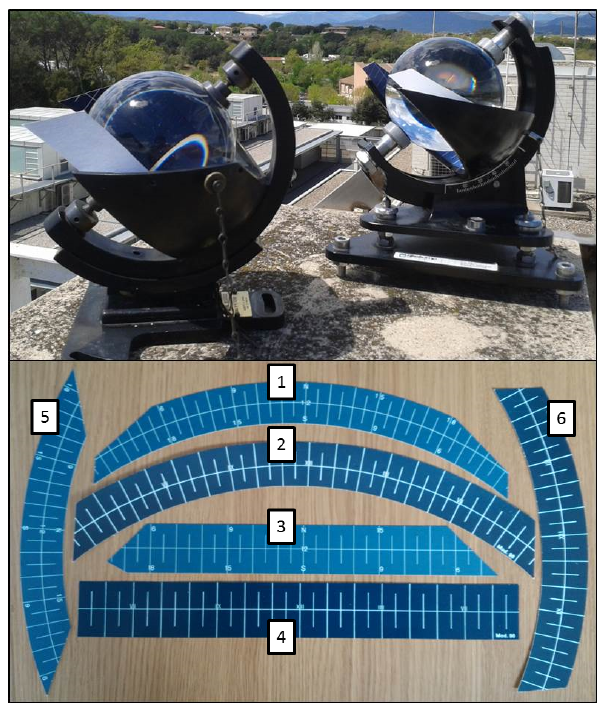
Figure 2. (Top) Details of the two different CSSRs mounted in Girona (NE Spain), and (bottom) an example of the 3 types of cards used during summer, winter, and equinoctial seasons, respectively (the longer the daylight hours, the longer the card): (1) summer card of Thies Clima; (2) summer card of Mod.98; (3) equinoctial card of Thies Clima (note that although the card edges are not symmetric, the markings are); (4) equinoctial card of Mod.98; (5) winter card of Thies Clima; and (6) Winter card of